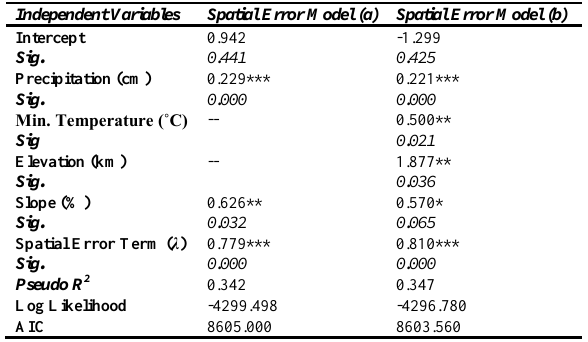
Table 6. Re-estimated spatial error models of relationships between SOC (dependent variable) and environmental factors (independent variables) (n=1,317). Model (a) includes two independent variables of precipitation and slope. Model (b) also includes minimum temperature and elevation.